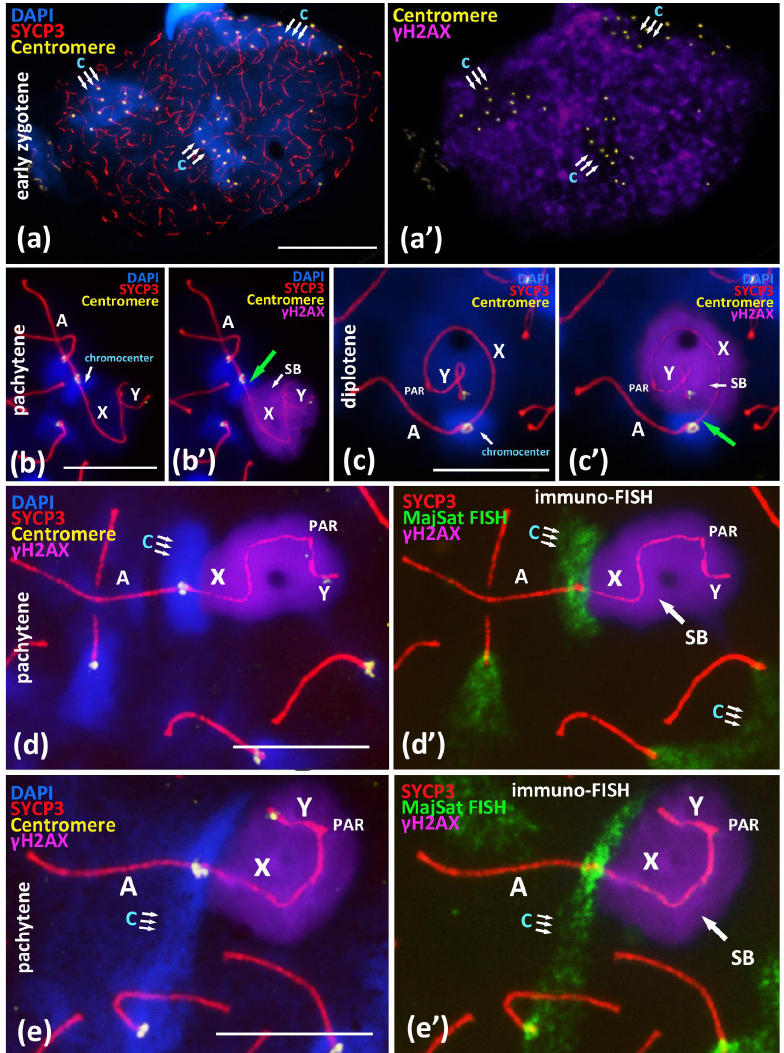
Figure 3. Immuno-FISH study of chromocenters and γ H2AX-dependent chromatin inactivation in F 3 early zygotene and in the associations between X chromosome and autosomal bivalents in pachytene, BALB/c mouse. Chromatin was stained with DAPI (blue), axial elements of meiotic chromosomes were immunostained with the antibodies against the SYCP3 protein (red), centromeres were stained with the ACA antibodies (yellow), and inactivated chromatin was immunostained with the anti- bodies against γ H2AX. FISH with oligo-DNA probes to MajSat DNA (green). Scale bar—10 µ m. ( a )—Early zygotene spread nucleus with 3 DAPI-rich chromocenters (‘c’, triple arrows) composed of clustered pericentromeric regions of chromosomes; immunostained centromeres (40 yellow foci).